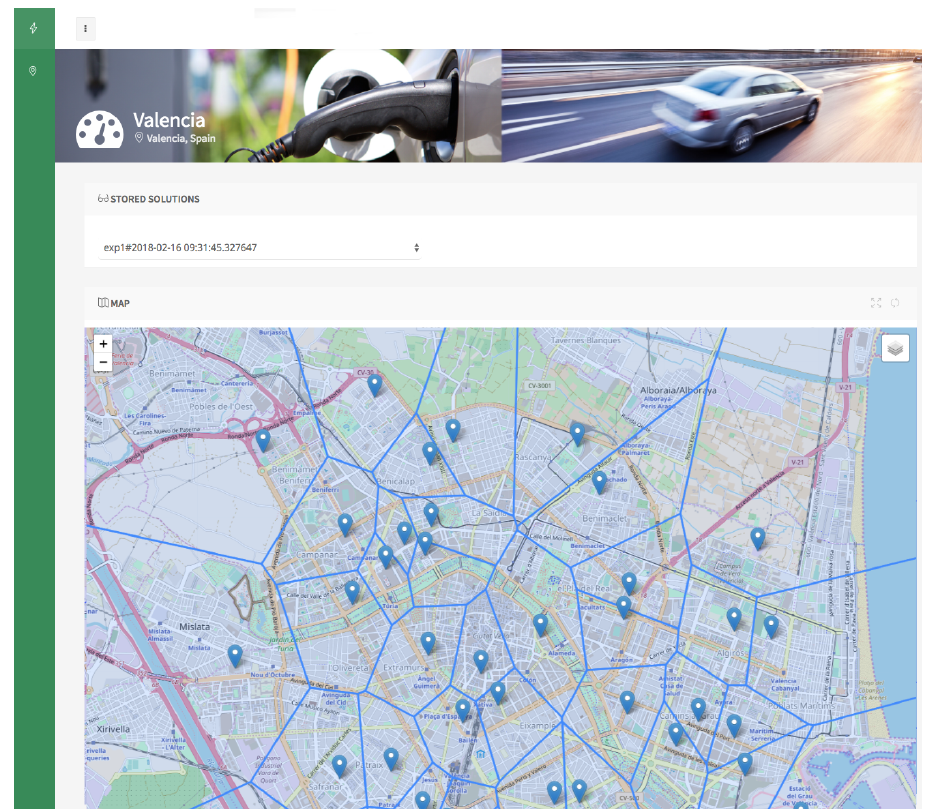
Figure 5. Configuration of the location of the charging stations displayed by the User Interface Agent